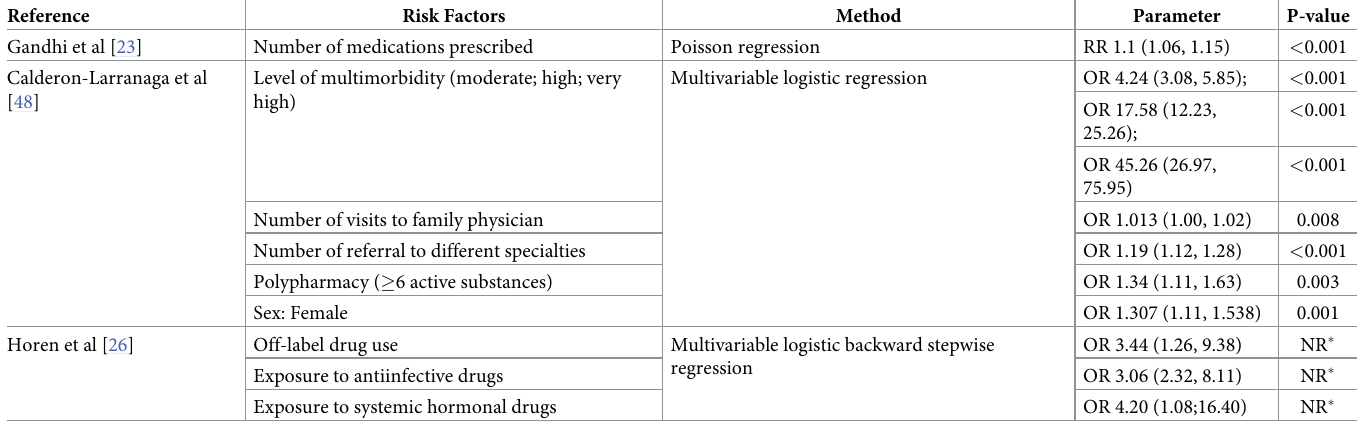
Table 5. Risk factors of ADRs in the primary care